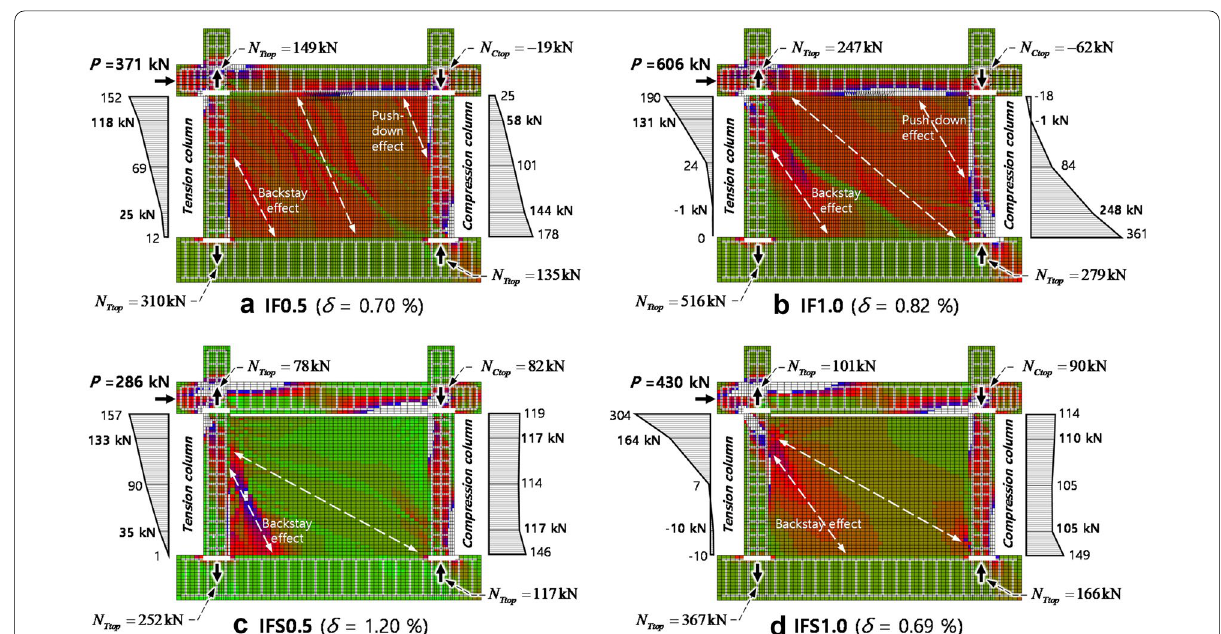
Fig. 10 Distributions of column shear and axial forces at the peak